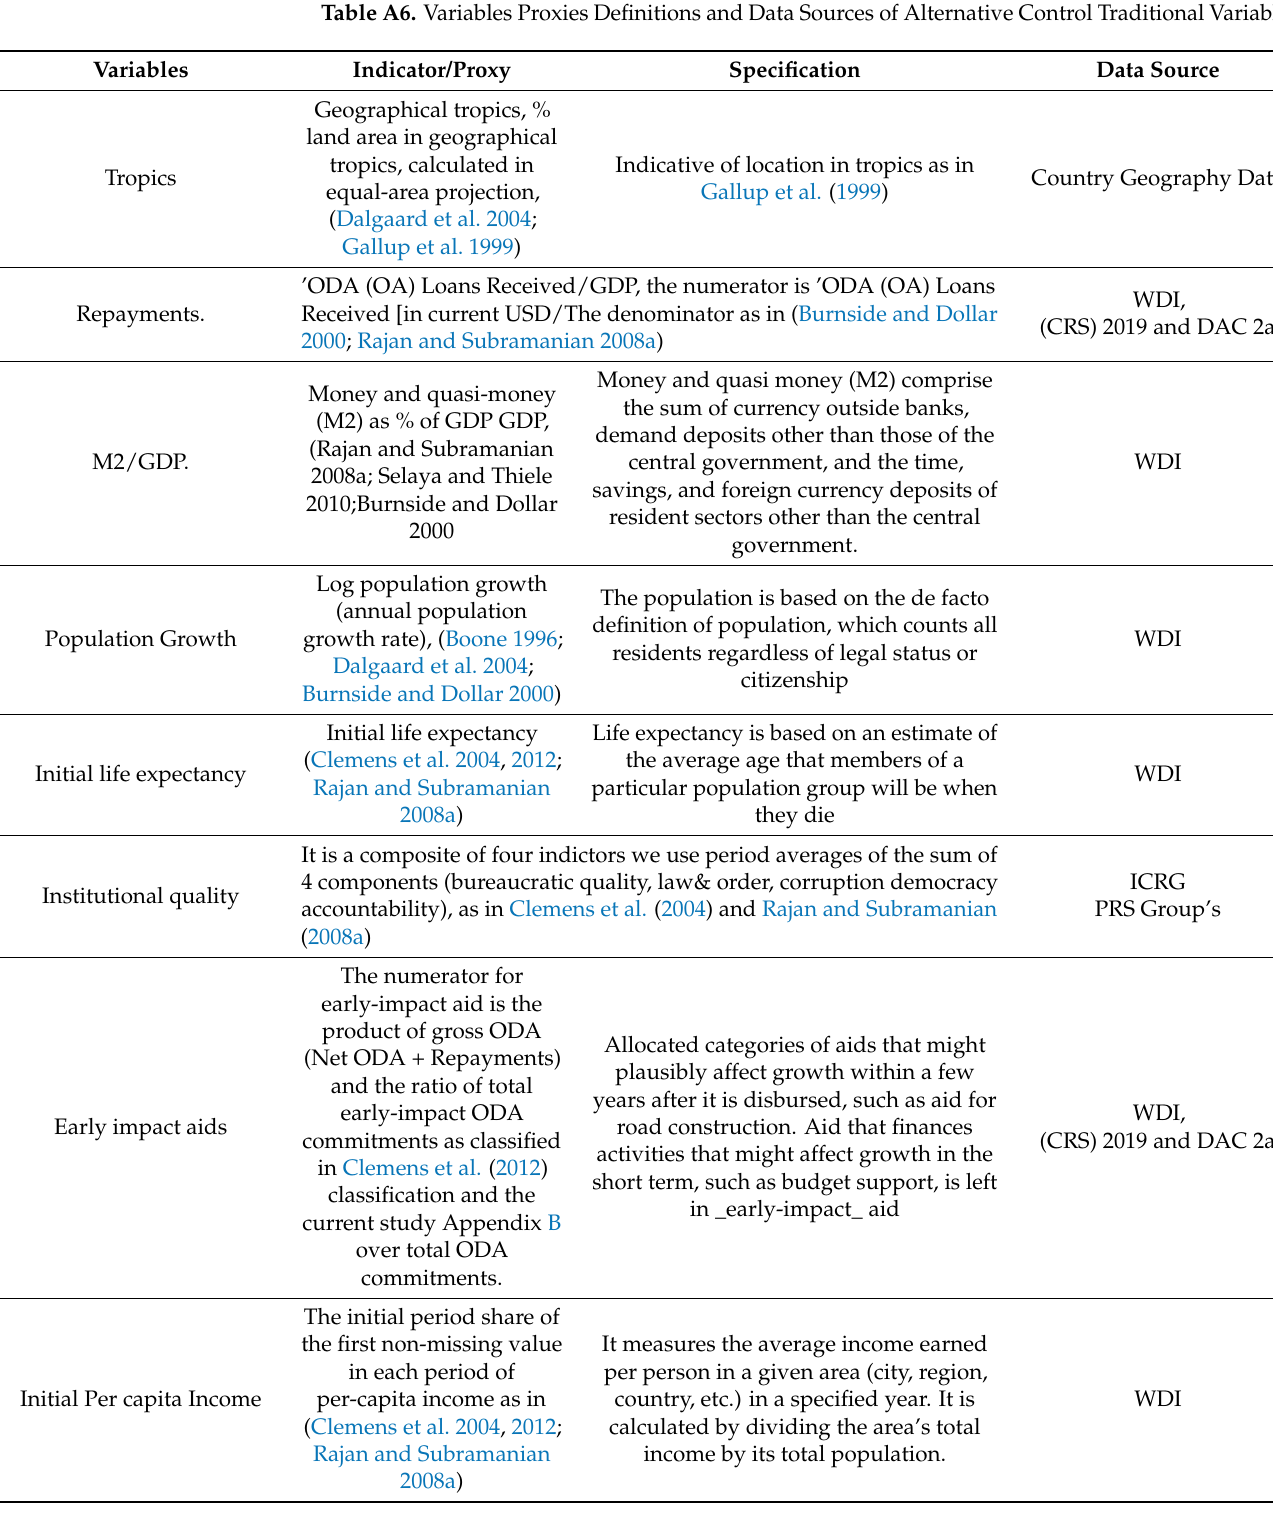
Table A6. Variables Proxies Definitions and Data Sources of Alternative Control Traditional